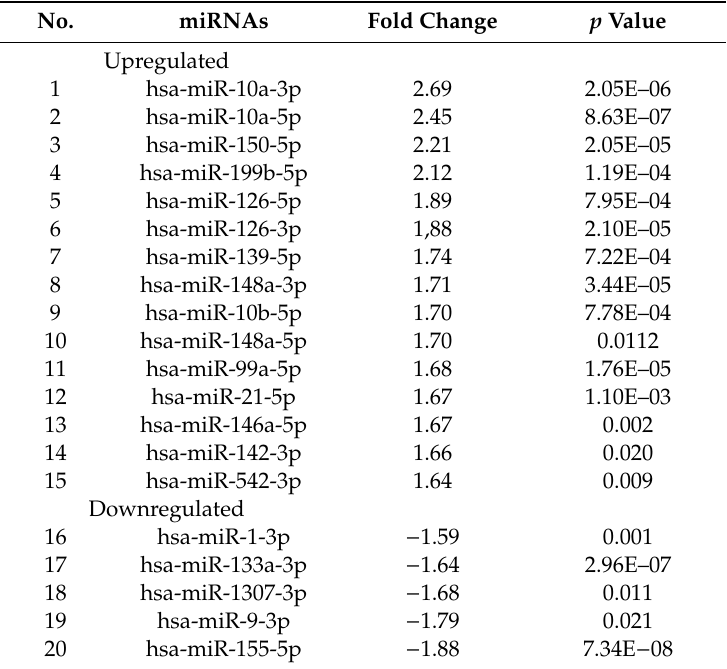
Table 3. List of di ff erentially expressed miRNAs (selection criteria were fold change > 1.5, p value < 0.05 and base mean higher than 10) in TAA aortic tissue samples compared to miRNA expression levels in non-TAA